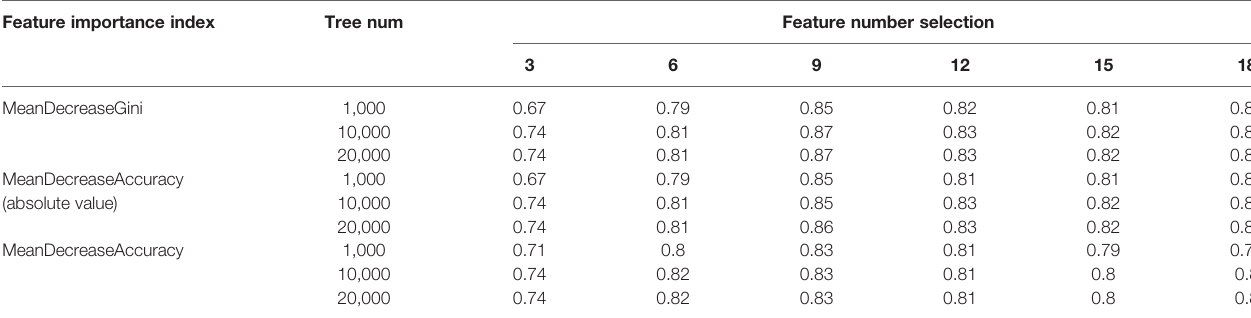
TABLE 2 | Hyper-parameter selection by cross-validation.